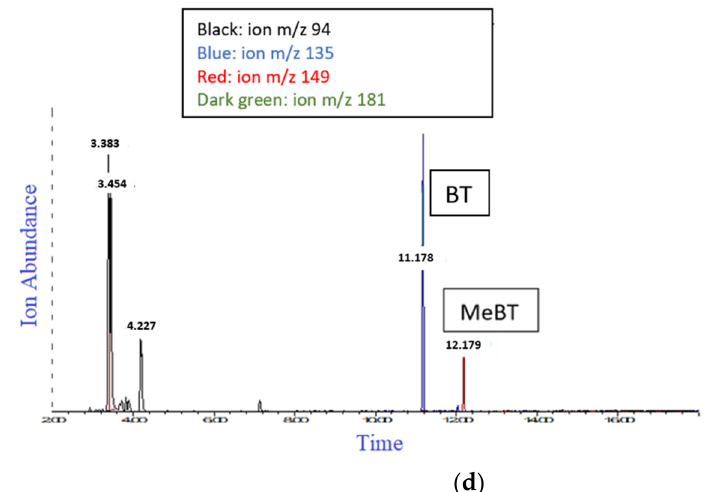
Figure 4 . Molecular ion extracted pyrograms of: ( a ) RM after-acetone extraction; ( b ) RM after-SW; ( c ) a devulcanized sample (test 5) after-acetone extraction; ( d ) the same devulcanized sample after-SW.